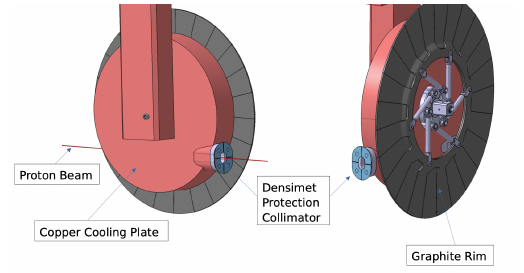
Figure 4. Full layout of the lower part of the TgH insert. The red line shows the trajectory of the proton beam, which impinges on the target from the